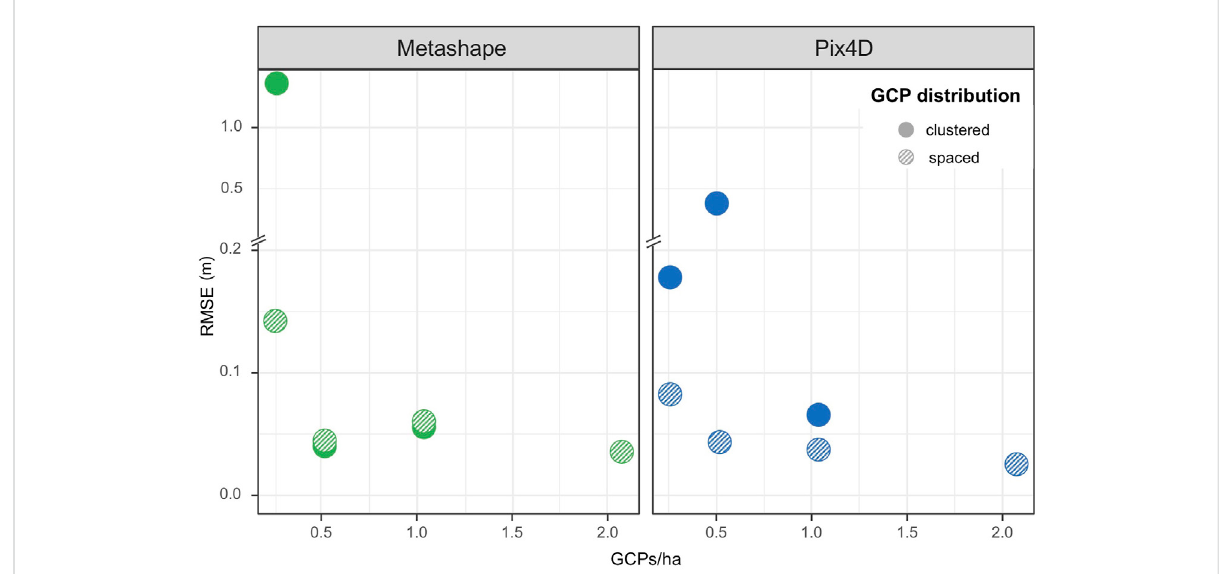
FIGURE 2 Vertical Root Mean Square Error (RMSE) is minimized at higher GCP densities with regularly spaced GCPs. Vertical RMSE is calculated from differences between SfM-computed DSM elevations and GNSS-recorded true elevations at checkpoints (n = 115) across the test site at Swan Island. Y -axes are segmented for visualization of extreme